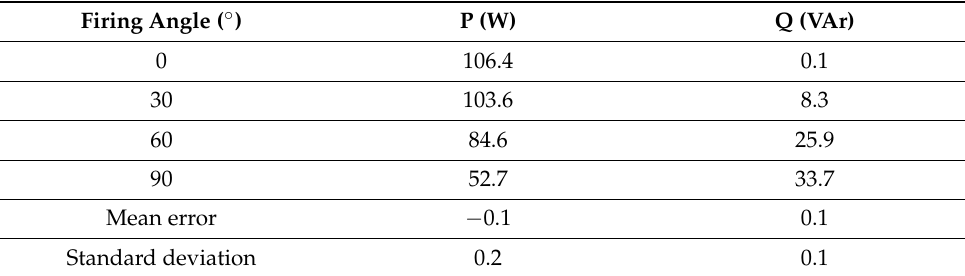
Table 14. Calculated values with fundamental components for the non-linear load.